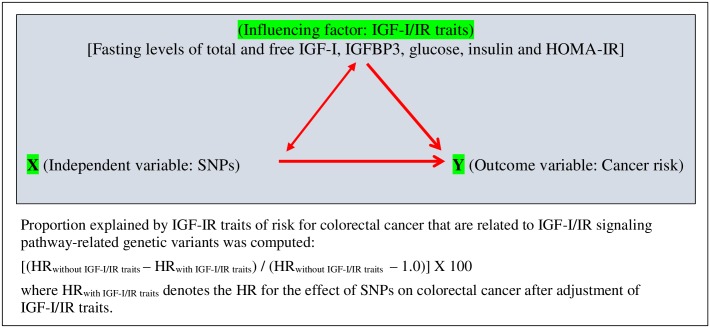
Pathways of SNPs in IGF-I/IR signaling pathways–related genes, IGF-I/IR traits, and colorectal cancer risk.(HOMA-IR, homeostatic model assessment–insulin resistance; HR, hazard ratio; IGF-I, insulin-like growth factor-I; IGFBP3, IGF binding protein 3; IR, insulin resistance; SNP, single-nucleotide polymorphism) Proportion explained by IGF-IR traits of risk for colorectal cancer that are related to IGF-I/IR signaling pathway-related genetic variants was computed: [(HRwithout IGF-I/IR traits−HRwith IGF-I/IR traits) / (HRwithout IGF-I/IR traits− 1.0)] X 100 where HRwith IGF-I/IR traits denotes the HR for the effect of SNPs on colorectal cancer after adjustment of IGF-I/IR traits.